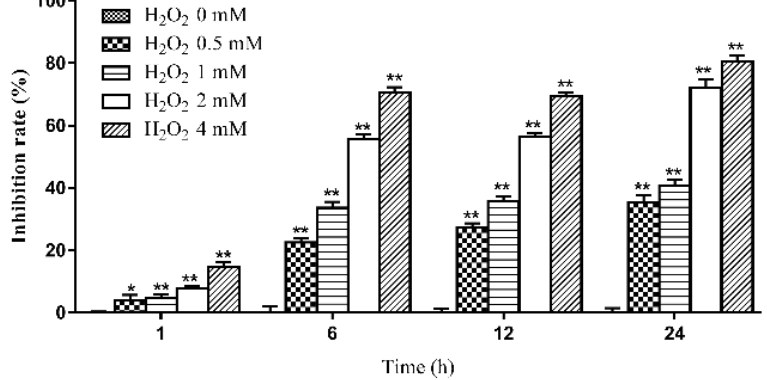
Figure 1. Effect of H 2 O 2 on the viability of IPEC-J2 cells (mean ± s.d., n = 5). Legend: * and ** indicate level of significance at p < 0.05 and p < 0.01, respectively, compared with the oxidative stress model group.